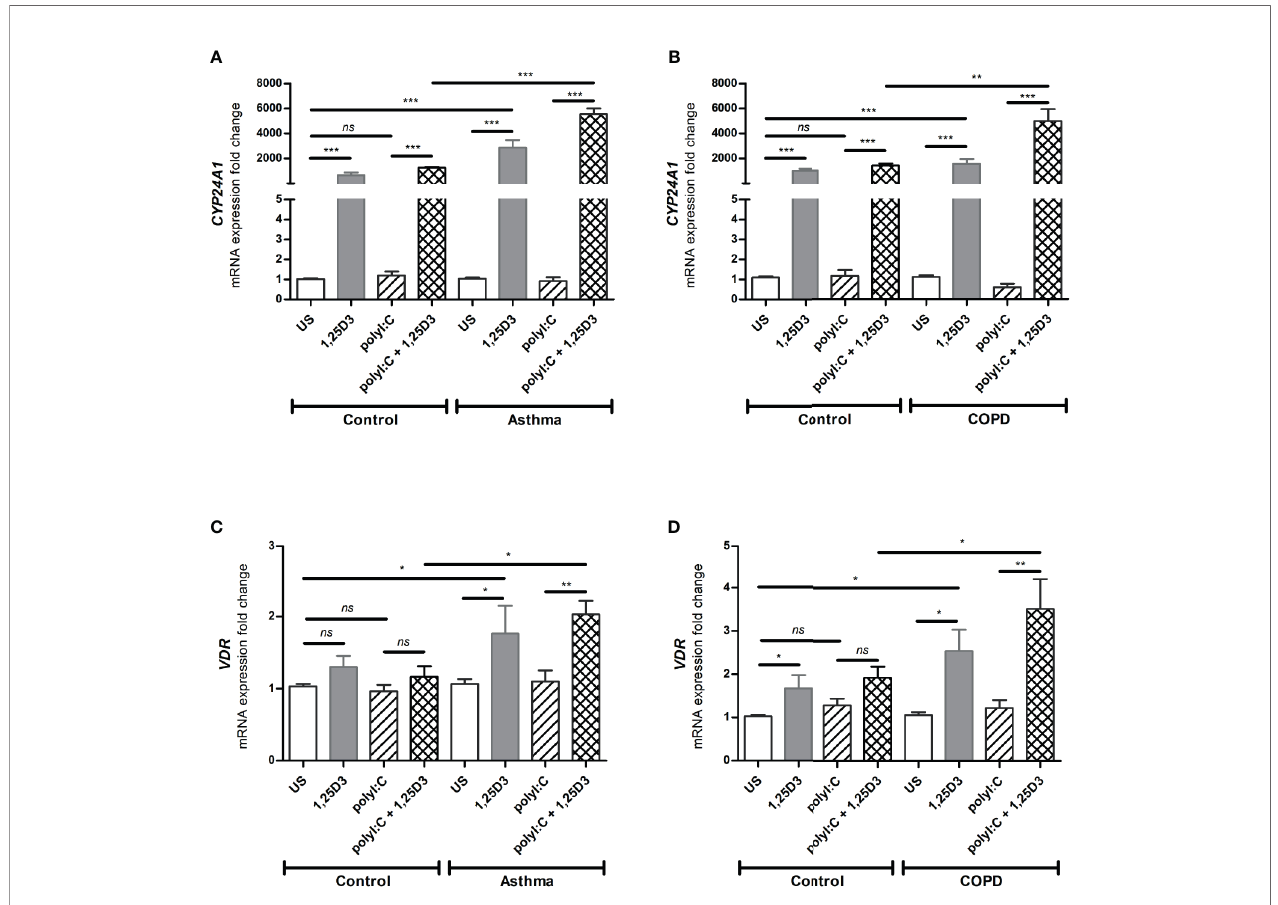
FIGURE 1 | mRNA expression of CYP24A1 (A, B) and VDR (C, D) in BSMCs from asthma (A, C) and COPD (B, D) compared to BSMCs from healthy control groups. n = 4 asthma, n = 3 healthy controls, n = 4 COPD, and n = 3 healthy control smokers. qRT-PCR data is representative of two independent experiments. One way ANOVA using Newman-Keuls multiple comparison test were performed to assess statistical signi fi cance between groups. Mean ± SE; ( ns ) p > 0.05, no signi fi cant difference, * p < 0.05, ** p < 0.01, *** p <